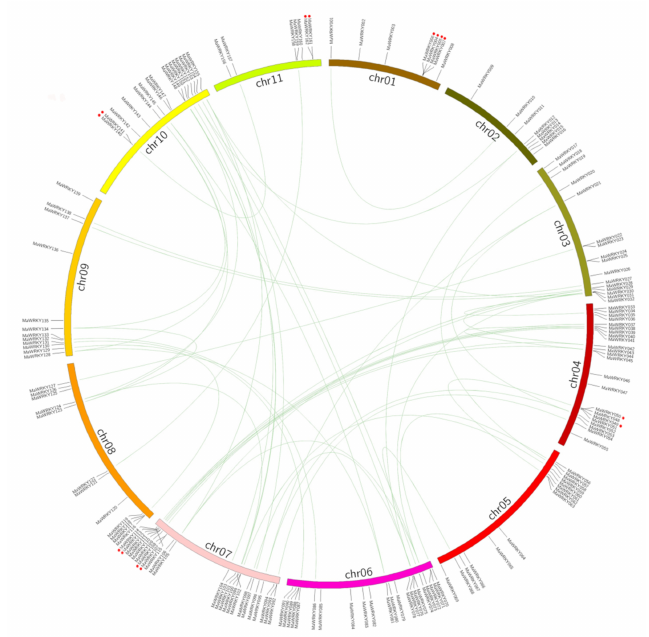
Figure 2. Distribution and synteny analysis of MaWRKYs on the 11 chromosomes. The vertical black line indicates the position of MaWRKY. The segmental duplicate MaWRKYs are connected with green lines. Tandem duplicates were marked with red dots.